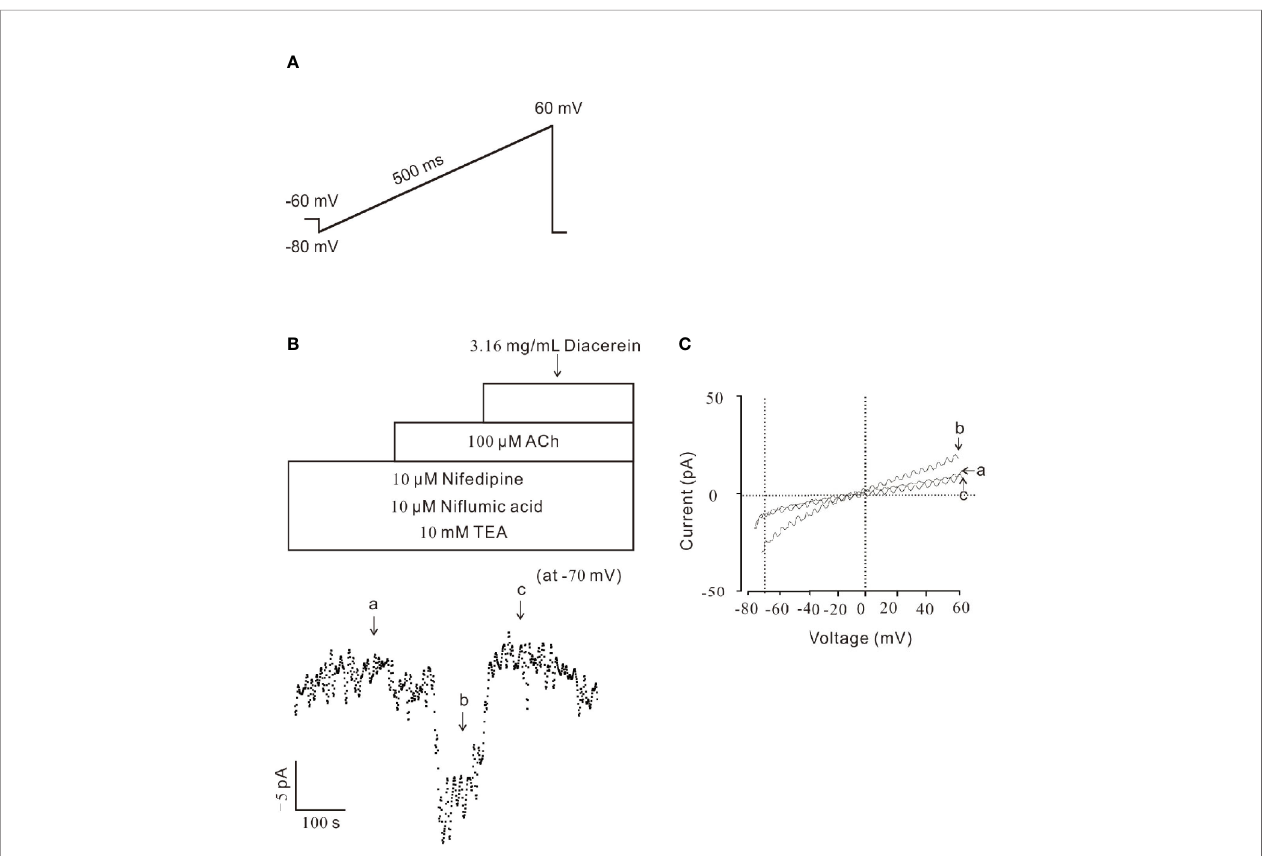
FIGURE 7 | Diacerein blocked non-selective cation channels (NSCC) currents. (A) The ramp clamp protocol was employed to record NSCC currents in single airway smooth muscle cells (ASMC). (B) To isolate NSCC currents, VDLCC currents, Cl − currents, and K + currents were inhibited by 10 m M nifedipine, 10 m M NA, and 10 mM TEA, respectively. Then 100 m M ACh-induced NSCC currents was inhibited by 3.16 mg/ml diacerein (n = 6/6 mice). The values at − 70 mV were obtained to plot current-time traces. (C) The net ramp currents at times a, b, and